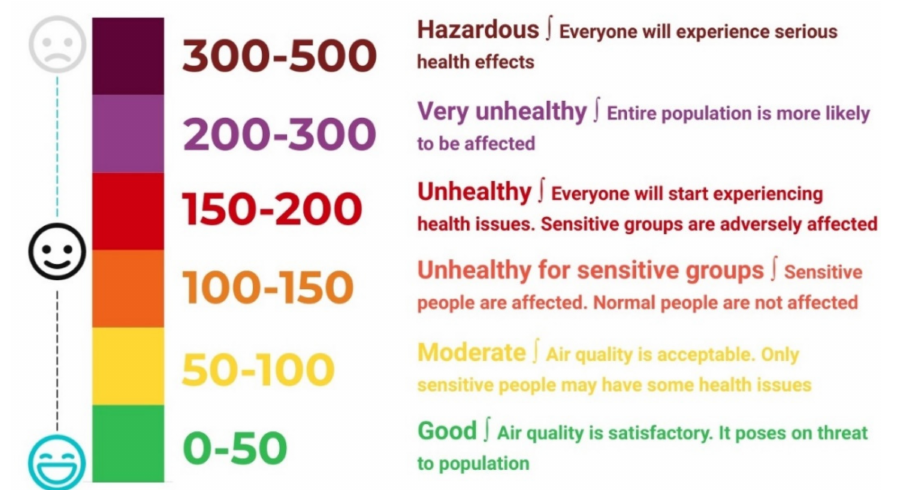
Figure 3. Air Quality Index